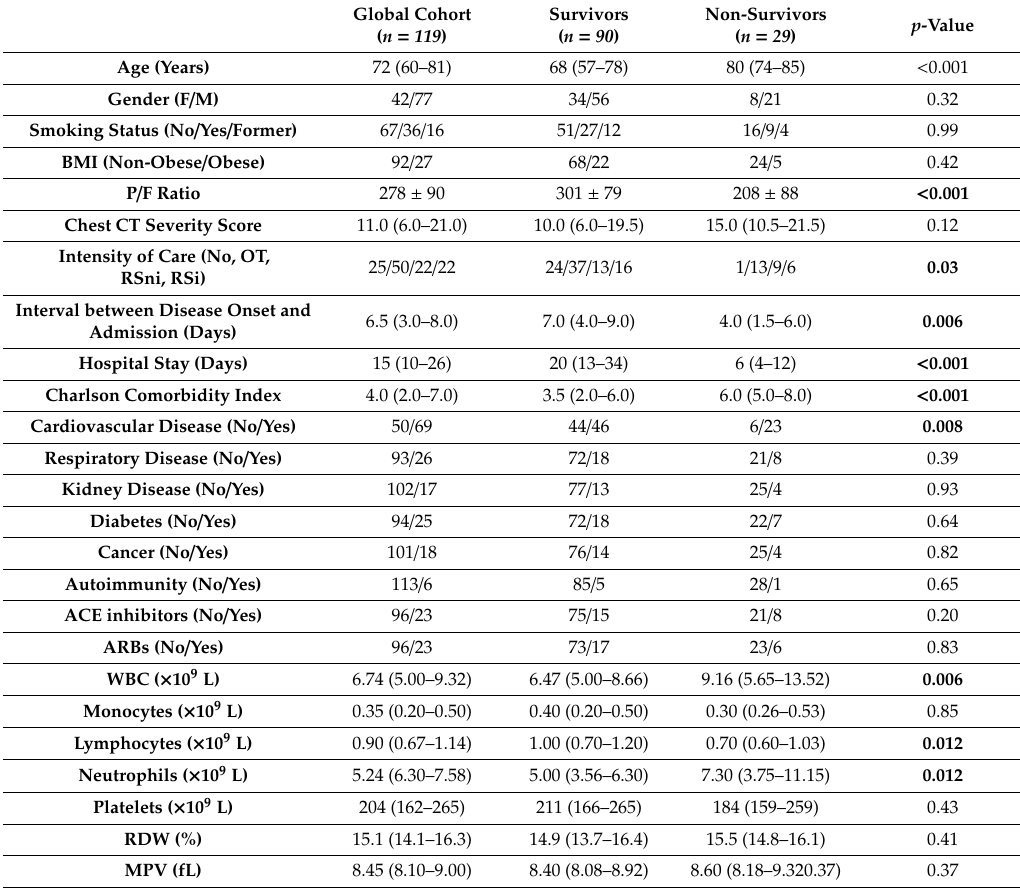
Table 1. Demographic, clinical, and hematological features of COVID-19 survivors and